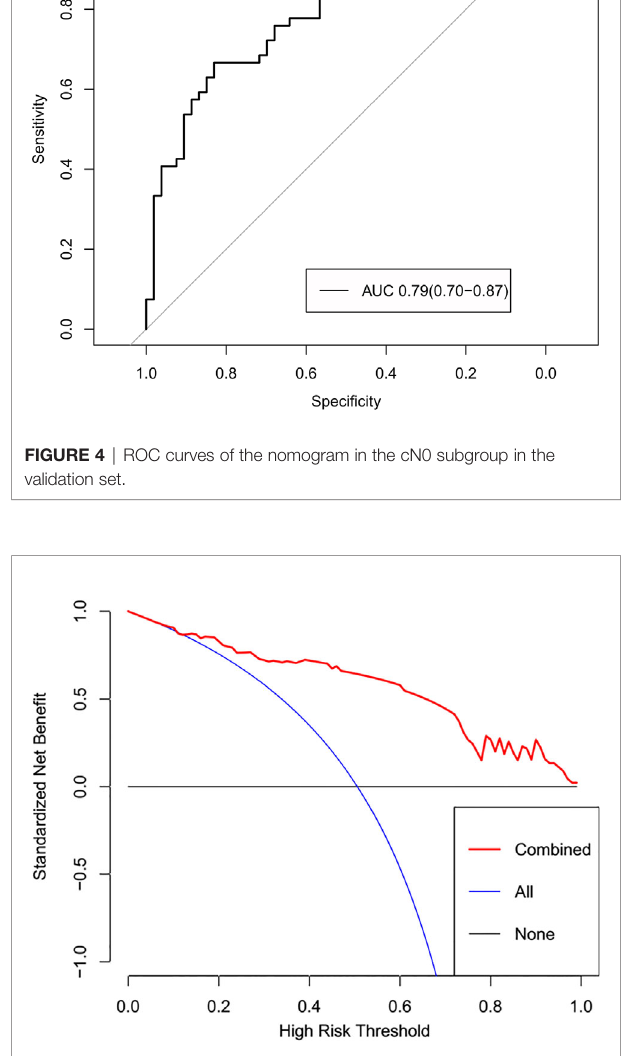
FIGURE 5 | DCA of the radiomics nomogram. The y axis represents the net bene fi ts, while the x axis represents the threshold probability. The red line represents the radiomics nomogram. The blue line represents the assumption that all patients were included in the lymph node metastasis group. The black line represents the assumption that all patients were included in the non- lymph node metastasis